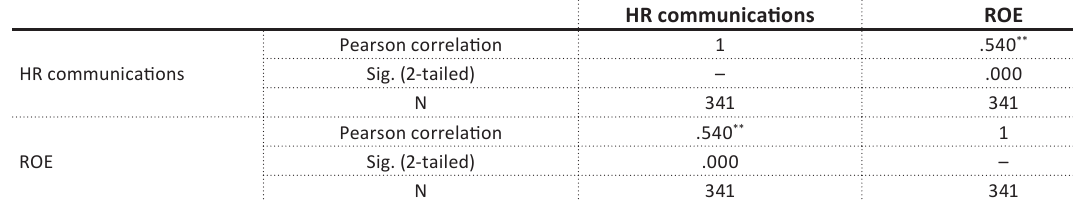
Source: Authors’ analysis using the